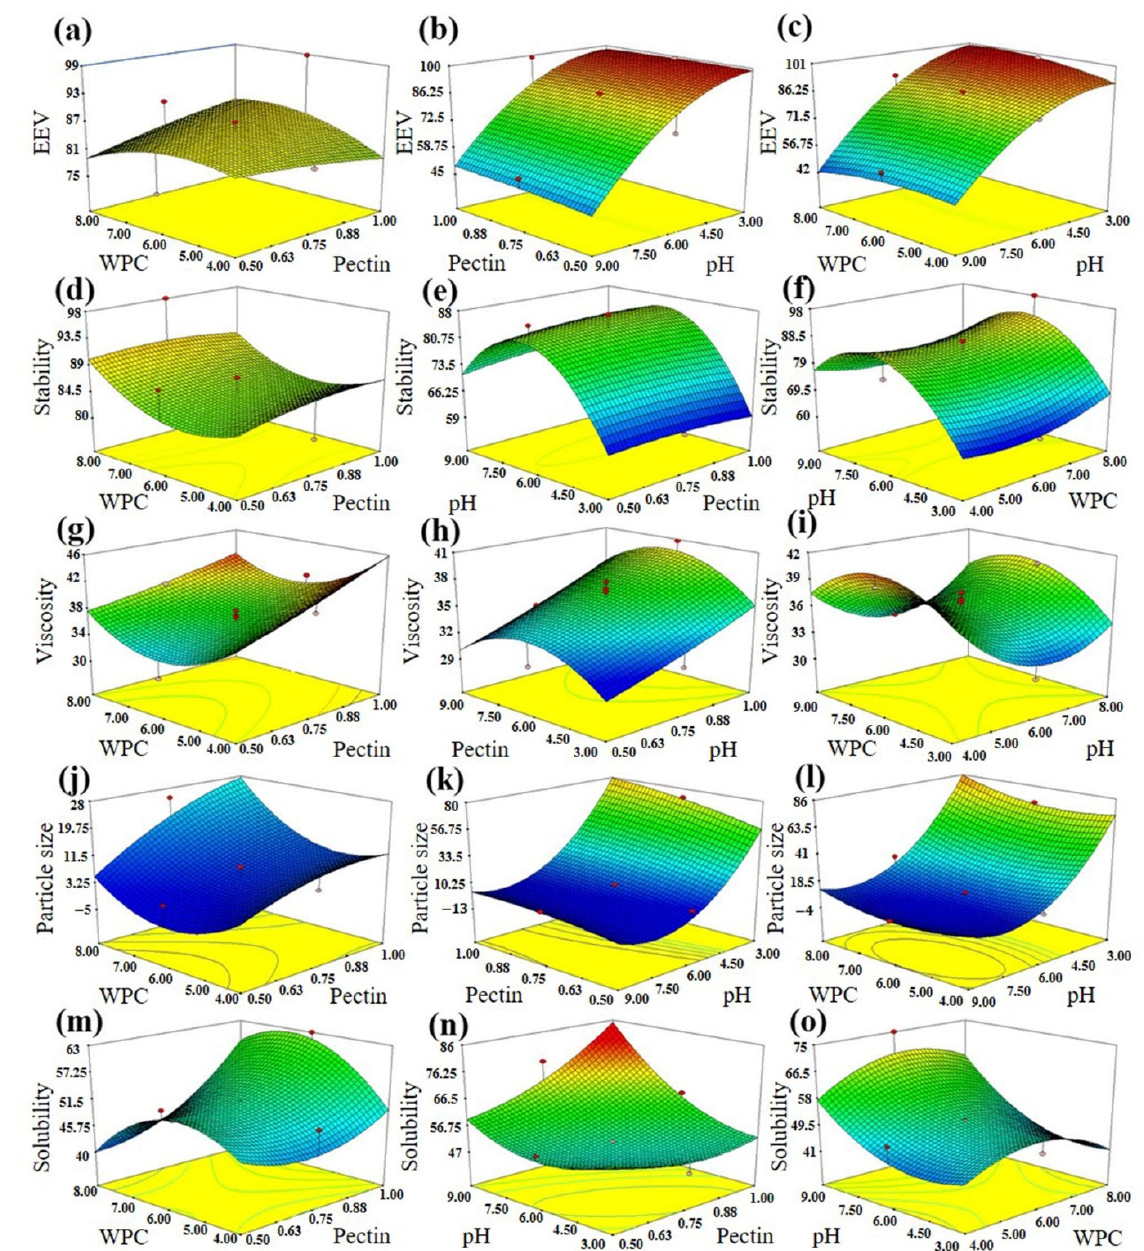
Figure 1. Effect of independent factors (pectin/WPC concentration and pH) on the encapsulation efficiency (EE) ( a – c ), stability ( d – f ), viscosity ( g – i ), particle size ( j – l ) and solubility ( m – o ) of vitamin B 12 –loaded complexes.